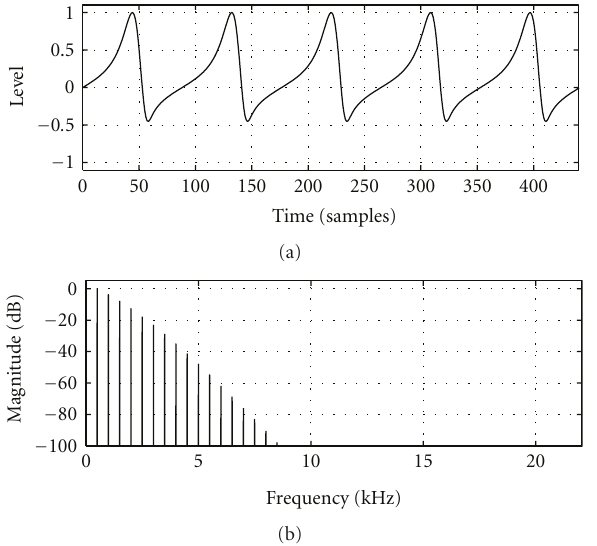
Figure 12: Waveform and spectrum of FBAM variation 2 ( β = 1, f 0 = 500Hz), see Figure